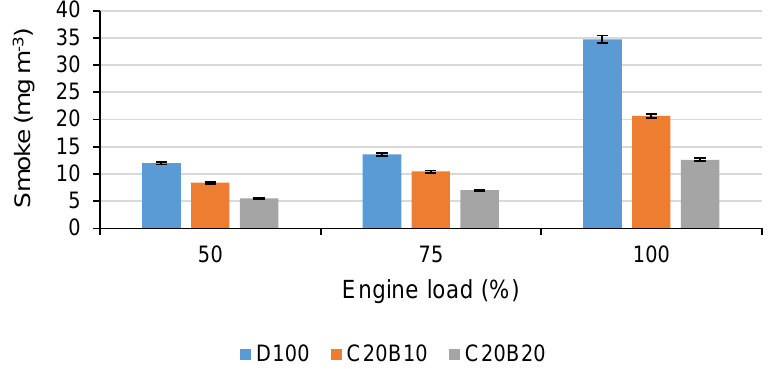
Figure 7. Engine smoke in relation to engine load for all tested fuels (error bars represent the accuracy of the opacimeter).